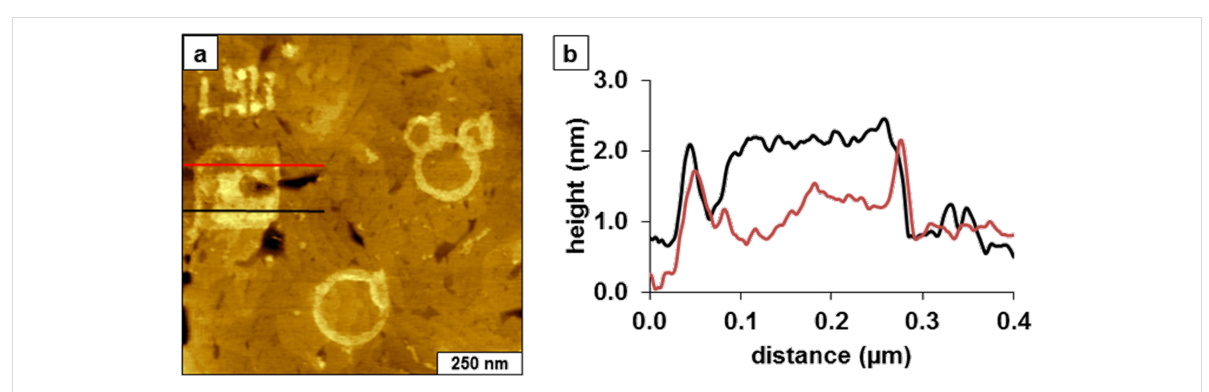
Figure 6: Nanografting of 11-mercaptoundecanoic acid (MUA) within a matrix of TMMH. (a) Topography view of multiple patterns that were nanografted within an 800 × 800 nm 2 region. (b) Cursor profiles across the terrace square of (a).